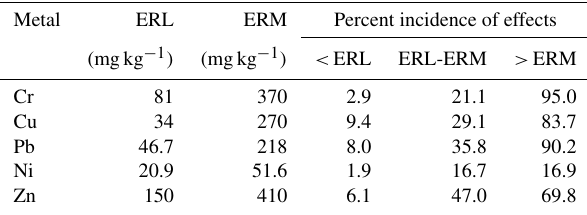
Table 7. ERL and ERM guideline values for trace metals (mgkg − 1 dry weight) and percent incidence of biological effects in concen- tration ranges defined by the two values.